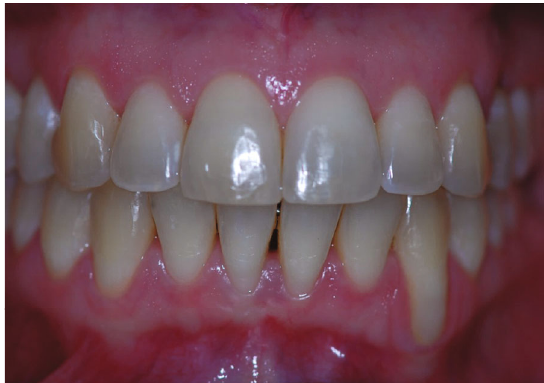
Figure 1: Preoperative front view of the patient showing a deep recession at #22.